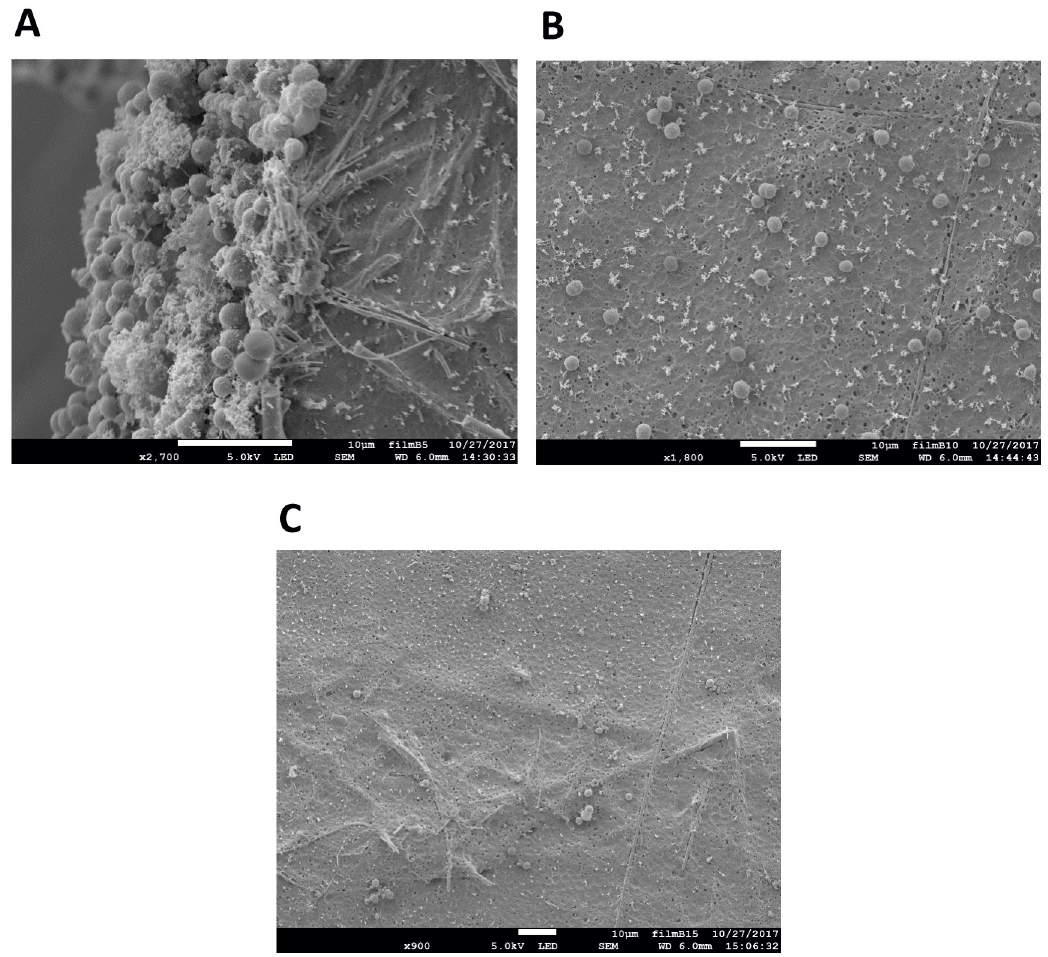
Fig 5. SEM of biofilm formation by Synechocystis on glass microfiber filter coated with PHB after 7 days of incubation. (A) 5 layers at 2700X magnification, (B) 10 layers at 1800X magnification, (C) 15 layers of PHB coating at 900X magnification (Bar is 10 μ m in each